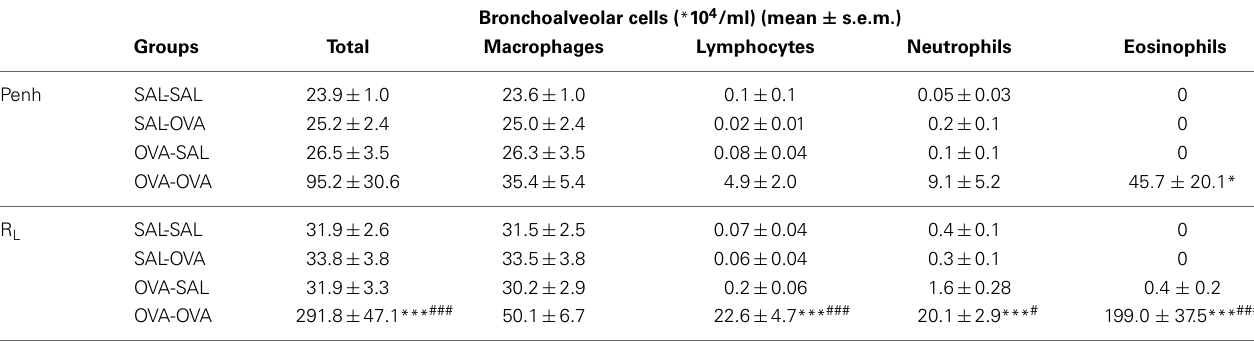
Table 3 | Total and differential cell counts in broncho-alveolar lavage fluid in the mild airway inflammation